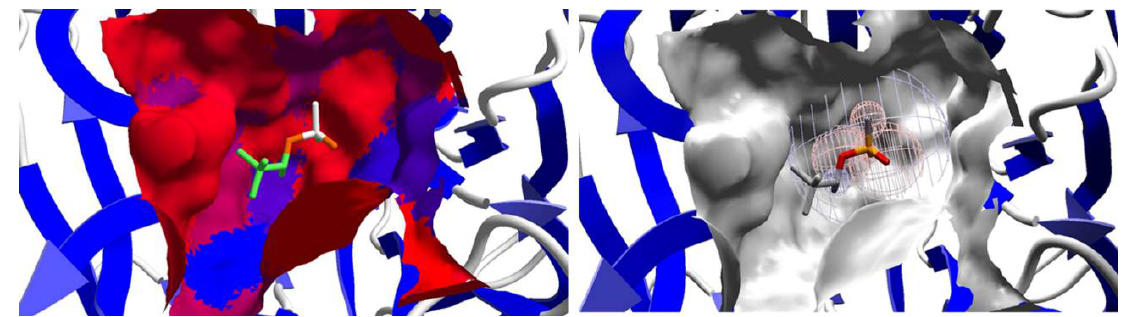
Figure 10. Representation of the hydrophobic (on the left) and electrostatic (on the right) interactions of Soman ( R P enantiomer) in the DFPase active cavity, wherein red surface means hydrophobic regions and blue surface means hydrophilic regions.